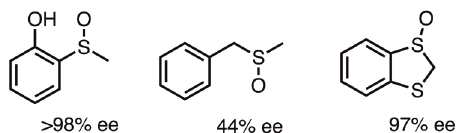
Figure 20 - Substrates for enantiomeric enrichment via deoxygenation using DMSO reductase from Citrobacter